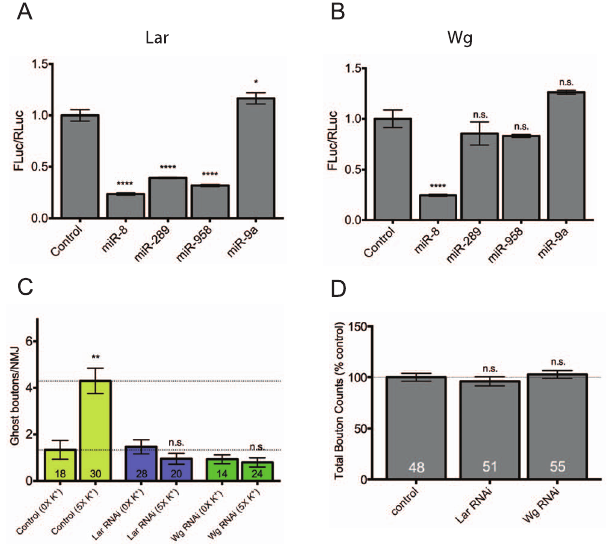
Figure 6. Drosophila lar and wg are authentic targets for translational repression by activity-regulated miRNAs. (A and B) Reporter plasmids constitutively expressing firefly luciferase (Fluc) flanked by the 3 9 UTRs of lar and wg were cotransfected into S2 cells with plasmids expressing the indicated miRNA primary transcripts as indicated. Renilla luciferase (Rluc) was included as a transfection control. Fluc activity was normalized to Rluc activity in three independent experiments. Normalized Fluc activities in the absence of miRNA- expressing vectors (emply vector controls) were set to 1. (A) The Drosophila lar 3 9 UTR has one binding site each for miRs-1, -8, -289, and - 958. miR-1 was not tested because it did not negatively regulate activity-dependent synaptic growth. miRs-8, -289, and -958 all significantly repress lar Fluc reporter activity. In contrast, a miRNA with no predicted binding site (miR-9a) has no effect on Fluc activity. (B) The wg 3 9 UTR has three predicted binding sites for miR-289 and two for miR-8. Interestingly, only miR-8 is capable of repressing wg Fluc reporter activity. miR-289, -958 nor -9a (not predicted to bind) had an effect of Fluc activity. In both (A) and (B) error bars indicate the mean 6 SEM (n=3). (C) Transgenic hairpin RNAi constructs targeting lar and wg were misexpressed in larval motor neurons using the C380-Gal4 driver (e.g. genotype C380-Gal4/ + ; UAS-RNAi hairpin / + ). Note that both hairpin constructs completely prevented activity-dependent ghost bouton formation. (D) Quantification of the total number of synaptic boutons at the same NMJs assayed in above (C). Neither hairpin construct had a significant effect on total bouton numbers compared to controls ( C380- Gal4/ + ) suggesting that activity-dependent processes may be more sensitive to disruption of genes involved in synaptic growth pathways. STATISTICS: (A-B; D) One-way ANOVA with a Dunnett’s post-hoc test. (C) Kruskal-Wallis multiple comparison analysis with a Dunn’s post-hoc test. n.s.=not significant ** p , 0.01 **** p ,